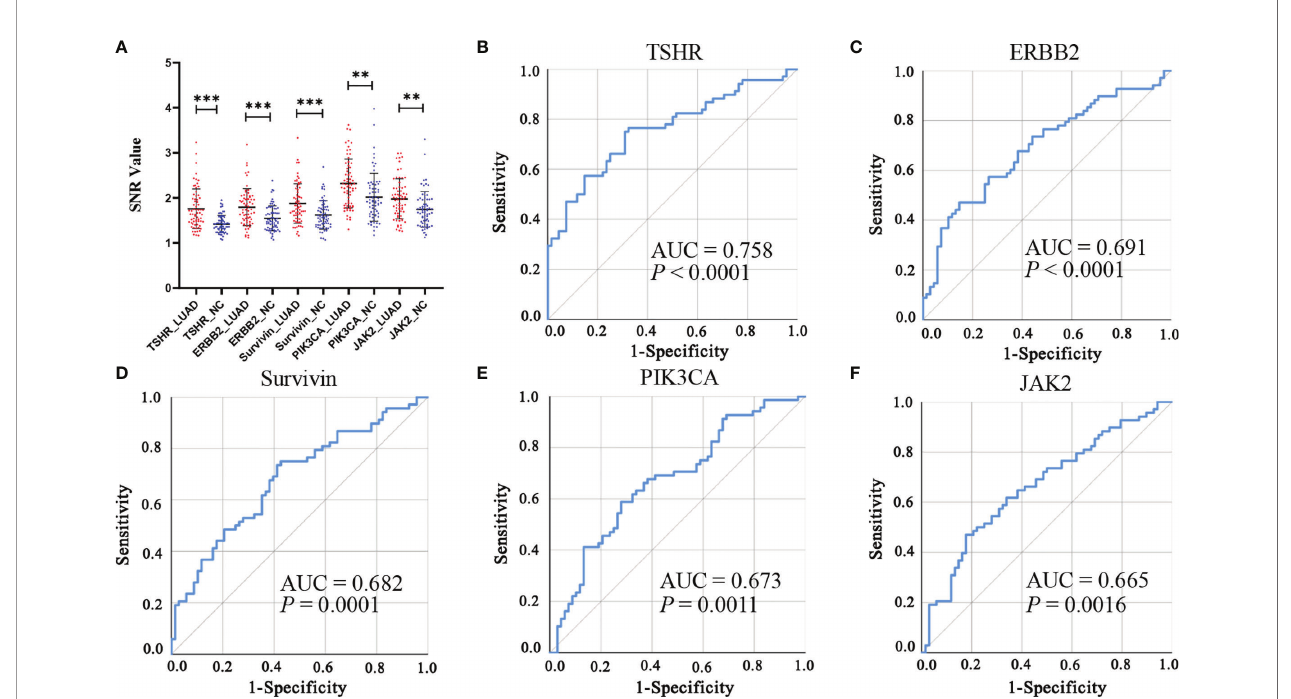
FIGURE 4 | (A) Differential expressions of the top 5 (AUC ranking) IgM autoantibodies in the discovery cohort using protein array. *** p < 0.001, ** p < 0.01. (B – F) ROC analysis of the top 5 IgM autoantibodies in the discovery cohort. AUC, area under the receiver operating characteristic curve; LUAD, lung adenocarcinoma; NC, normal control; ROC, receiver operating characteristic; SNR, signal-to-noise